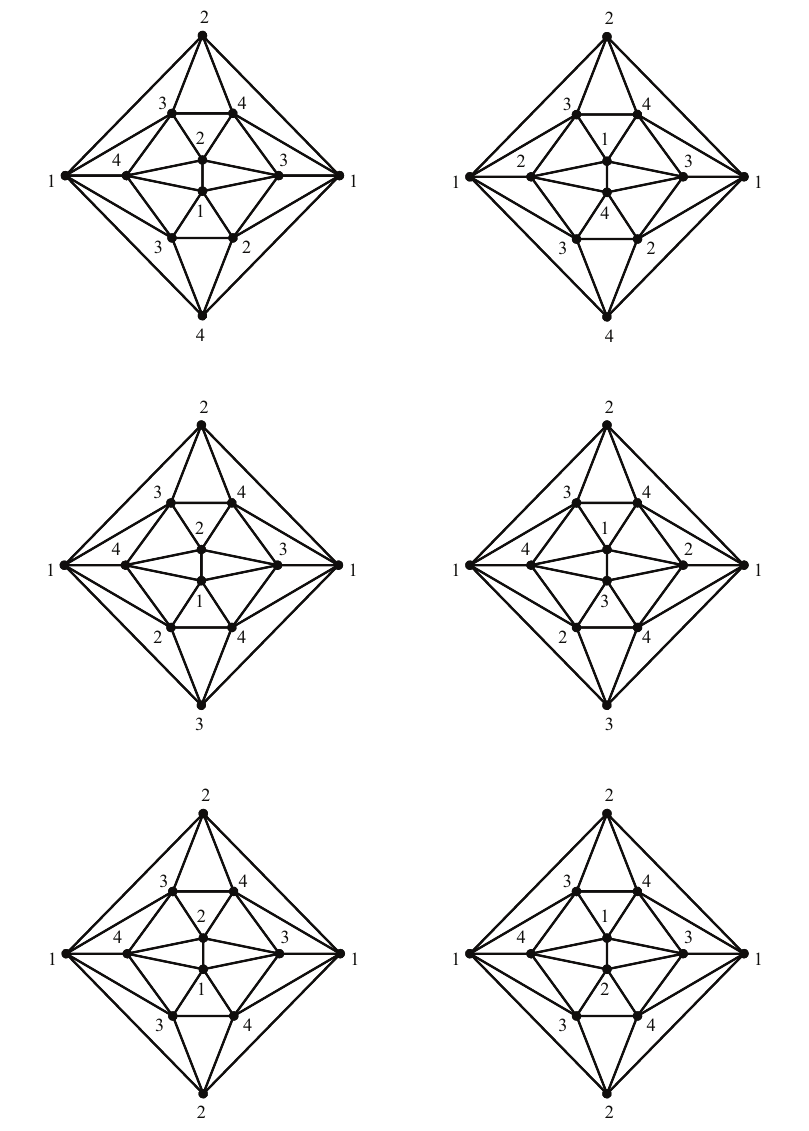
Figure 2. A near-triangulation of order 12 with all six of its distinct 4-colorings in which the colors of x and y are the same, without loss of generality color